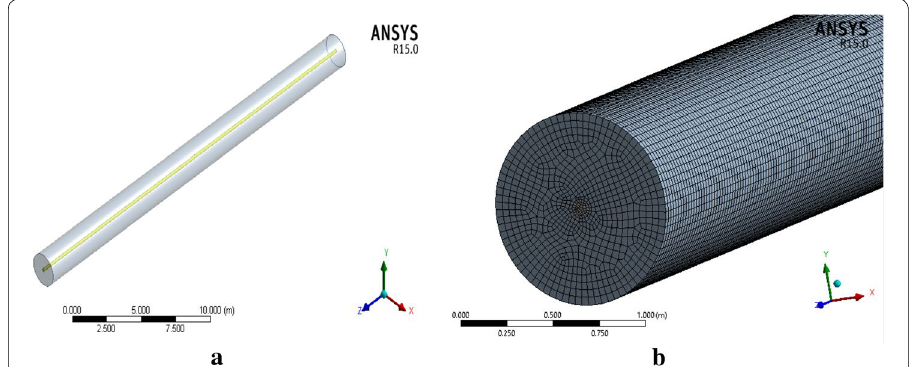
Fig. 2 a Physical model and b meshing of EATHE